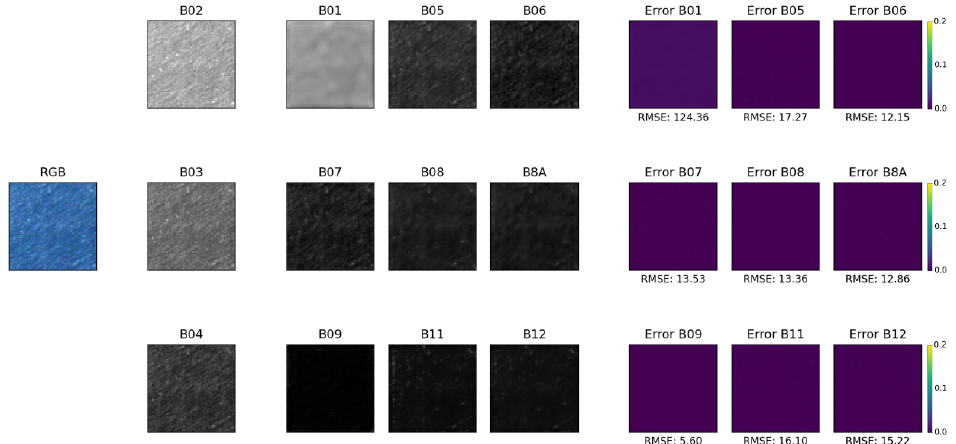
Figure 12. Error map as the absolute error between the each spectral band of a multispectral image of the ocean and the reconstructed image. From left to right by columns: RGB composite, red, green and blue channels, spectral reconstruction, and error map. To improve the visual inspection of the error, the scale has been adjusted between 0 and 0.2.